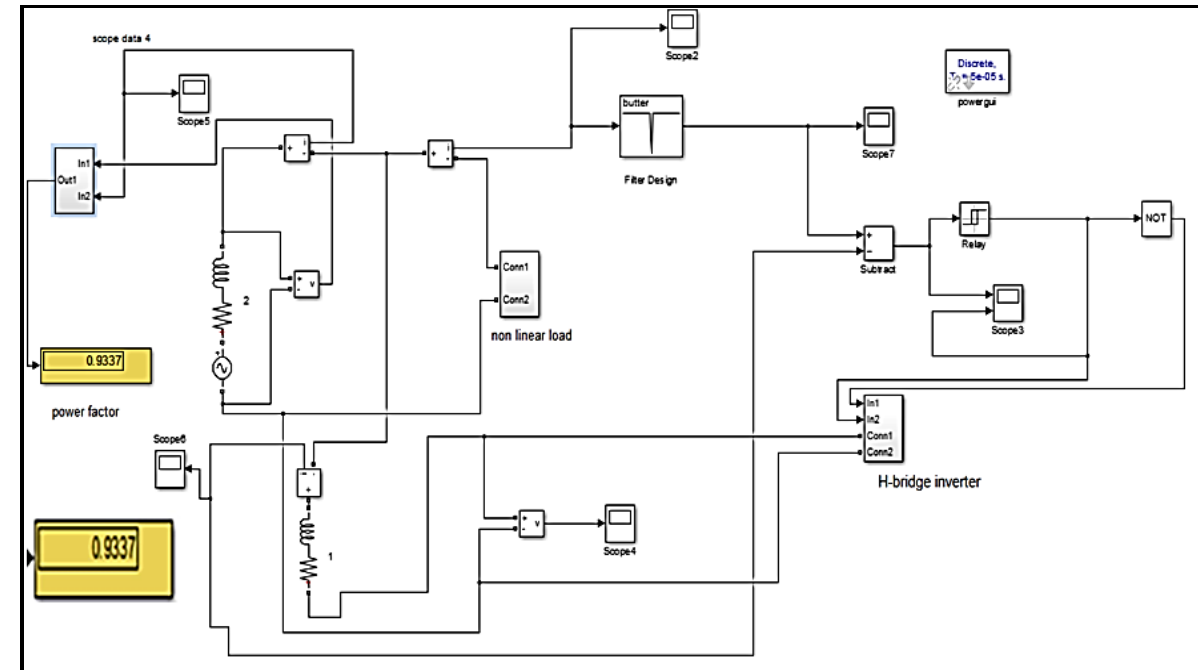
Figure 5. Simulation of single-phase SAPF by MATLAB/ Simulink environment.